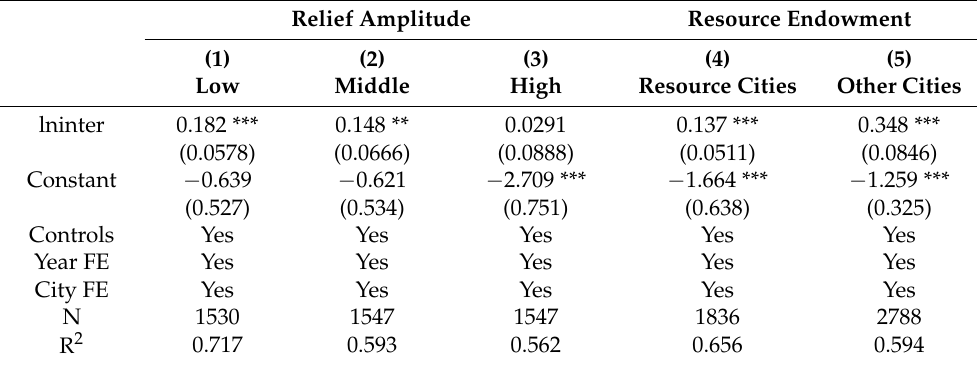
Table 8. The impact of geographical features and resource endowment. Relief